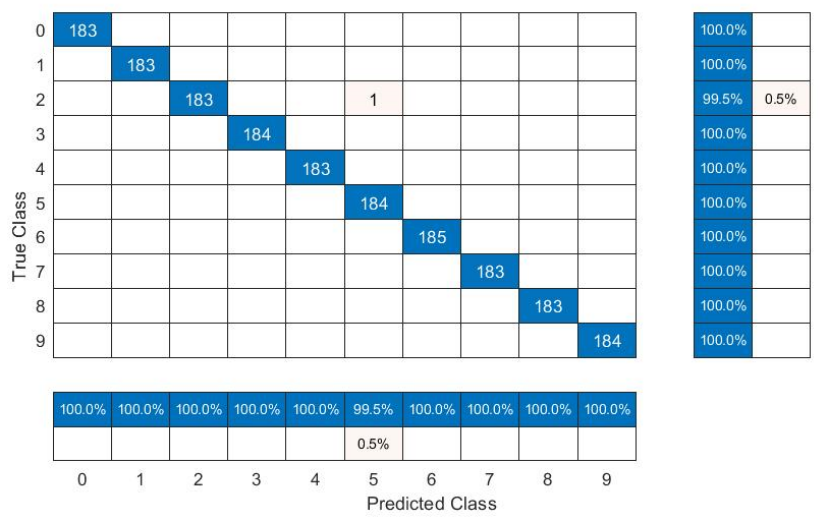
Figure 11. Confusion chart for ResNet18 (smallest training